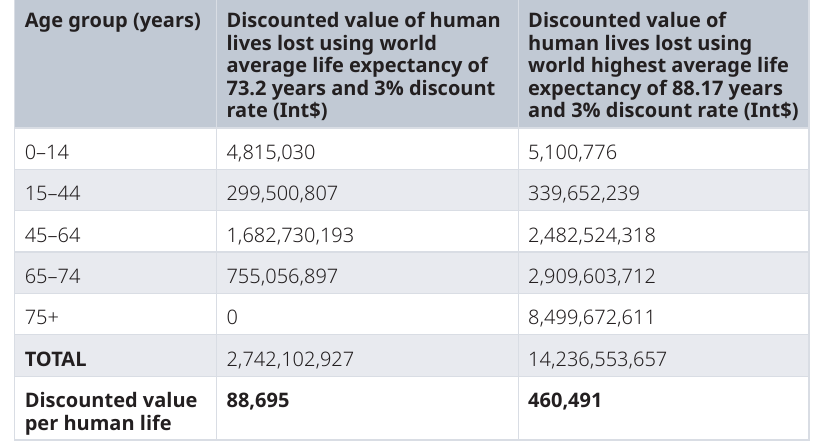
Table 9. Discounted value of human lives lost from COVID-19 in France, assuming the world and world’s highest average life expectancies (in 2020 Int$ or purchasing power parity